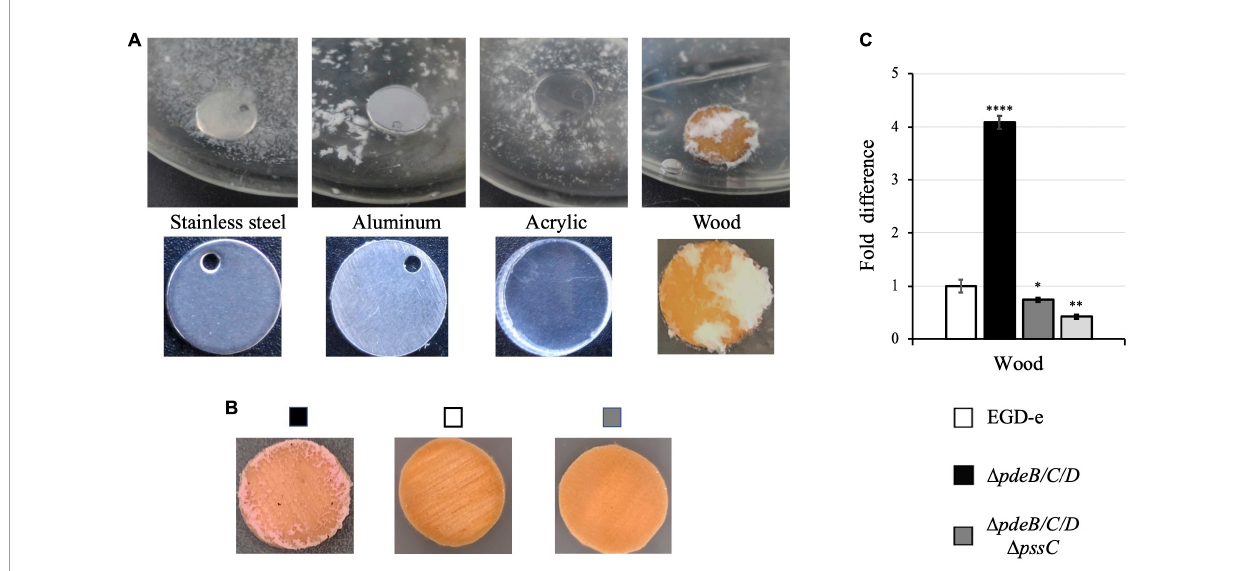
FIGURE1 The listerial Pss EPS enhances colonization of wood but not manmade materials. L. monocytogenes strains were grown in liquid HTM/GY medium at 30 ◦ C for 48 h in the presence of coupons (disks) made from wood and manmade materials. (A) The EPS-synthesizing strain ( (cid:49) pdeB/C/D ) grown in the presence of coupons made from stainless steel, aluminum and acrylic, and (unknown tree) wood forms voluminous biofilms only on wood coupons. (B) The EPS-synthesizing strain, but not wild type or the EPS-impaired strain ( (cid:49) pdeB/C/D (cid:49) pssC ), form biofilms on wood coupons. All strains express red fluorescent protein mScarlet, which turns biomass pink ( Table 1 ; Bindels et al., 2017). (C) Comparison of the CFU numbers in biofilms formed by various strains on the wood coupons following removal of the loosely attached biomass by rinsing. Shown are fold-differences compared to the wild type (EGD-e). The average CFU numbers of the wild type were 8.0 × 10 8 CFU per coupon. Data are from three independent experiments with at least two replicates in each experiment. Error bars represent standard deviations. Significant differences, compared to EGD-e, are indicated as follows: ∗ P < 0.05, ∗∗ P < 0.01, and ∗∗∗∗ P <